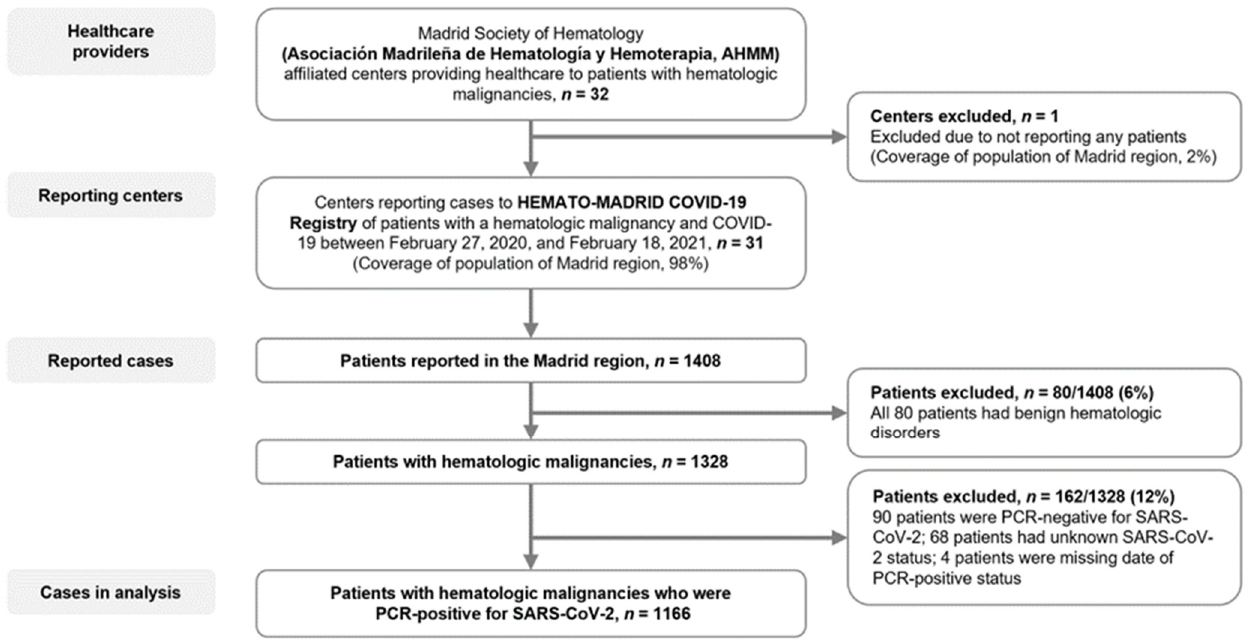
Figure 1. Flow diagram. Patients with hematologic malignancies who were reported as having COVID-19 and who were included in the present analysis. Reporting hospitals included 25/26 Madrid regional health service centers (8/8 designated high complexity level hospitals (CLH); 12/12 intermediate CLH; 5/6 low CLH), and 6/6 private centers. Table 1. Baseline characteristics of, and therapy received by, patients with hematologic malignan- cies and COVID-19.